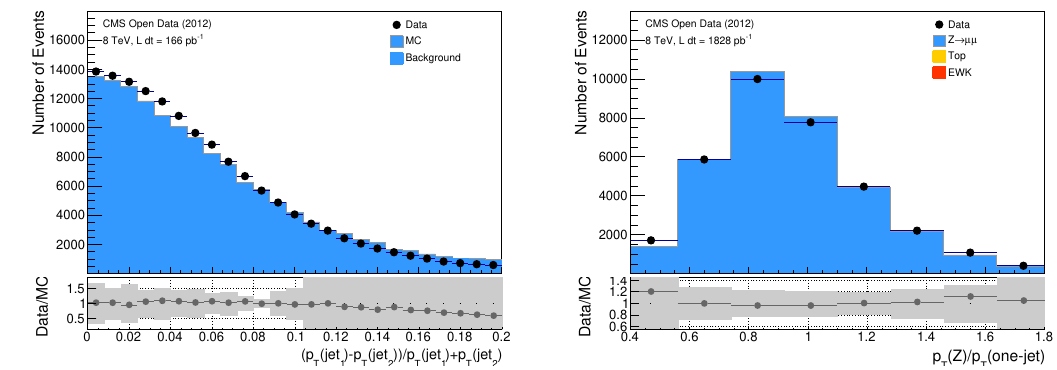
Figure 3 . Left: distribution of the (cid:1) rel of the ratio of measured p T ( Z ) and the measured jet energy E T for Z -boson events in the muon decay channel with exactly one jet with E T > 30 GeV and 20 < p T ( Z ) < 50 GeV for Data and MC. All MC-corrections have been applied. The grey band indicates the corresponding systematic